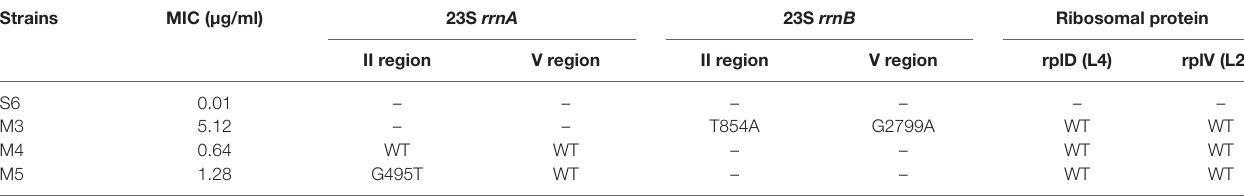
TABLE 5 | Mutations in the 23S rRNA gene and the ribosomal protein gene in M3, M4, and M5 strains.